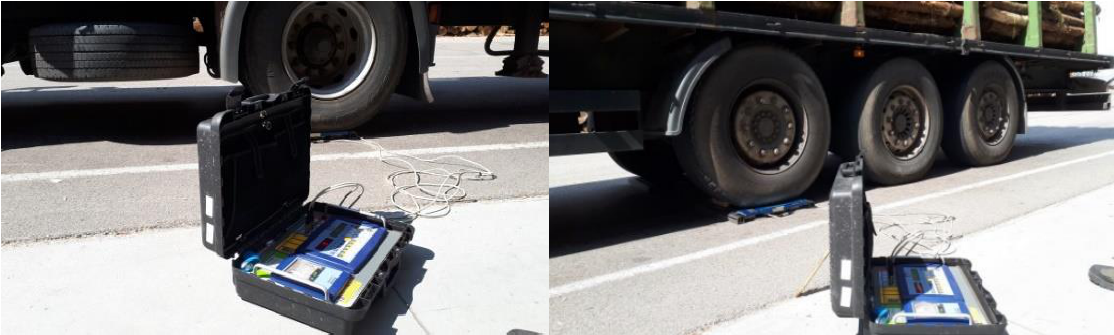
Figure 3. Measurement of the load of the individual axles of the transport set made by the platform scales model DINI ARGEO WWSD.